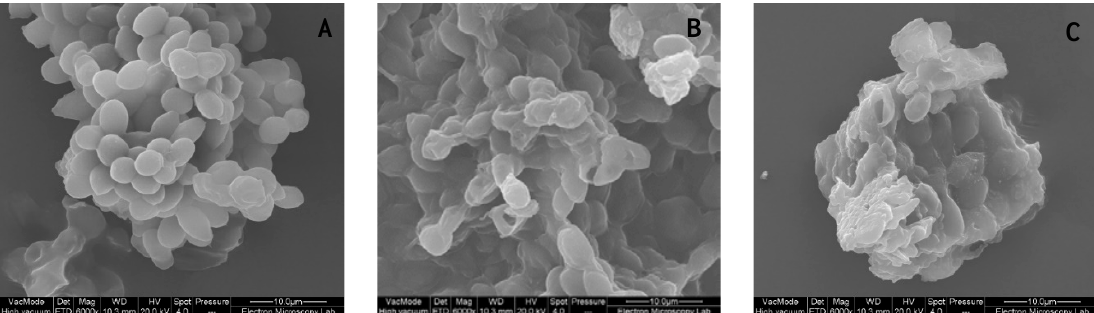
Figure 6. SEM images depicting X. dendrorhous ( A ) intact cells, ( B ) after Accelerace 1500 pre-treatment, and ( C ) after Glucanex pre-treatment.